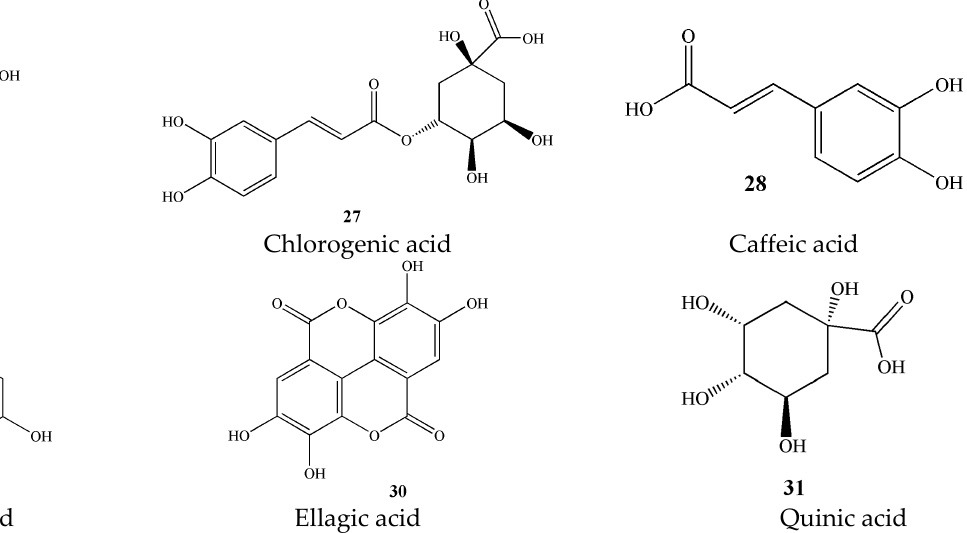
Figure 4. Chemical structures of phenolic acids isolated from green tea.